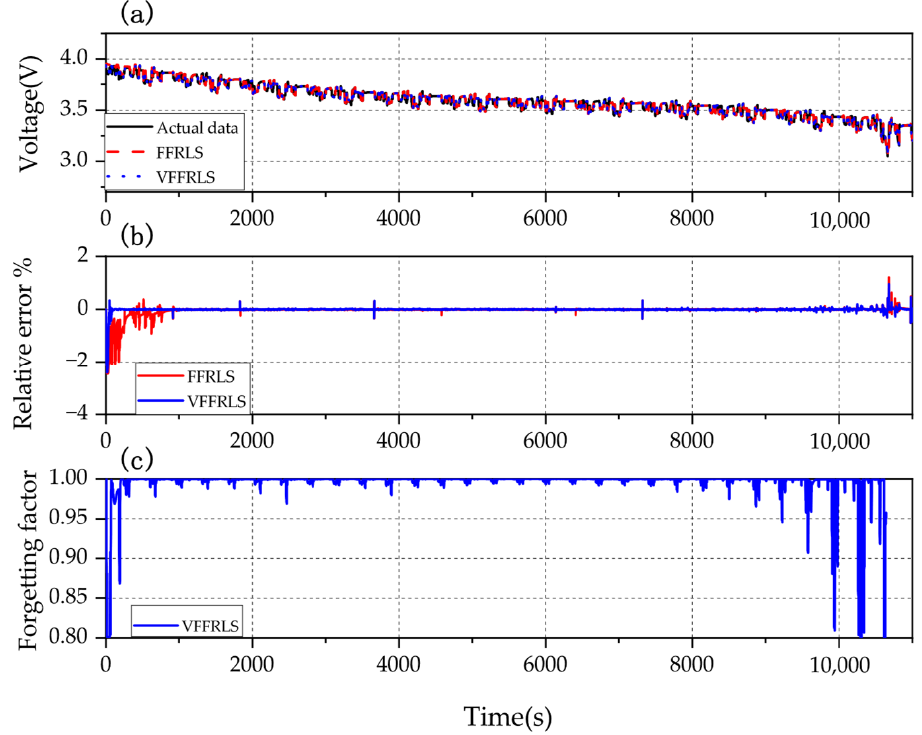
Figure 6. BJDST under 25 ◦ C: ( a ) actual voltage, predictive voltage of FFRLS and VFFRLS; ( b ) relative error of VFFRLS and FFRLS; ( c ) forgetting factor λ of